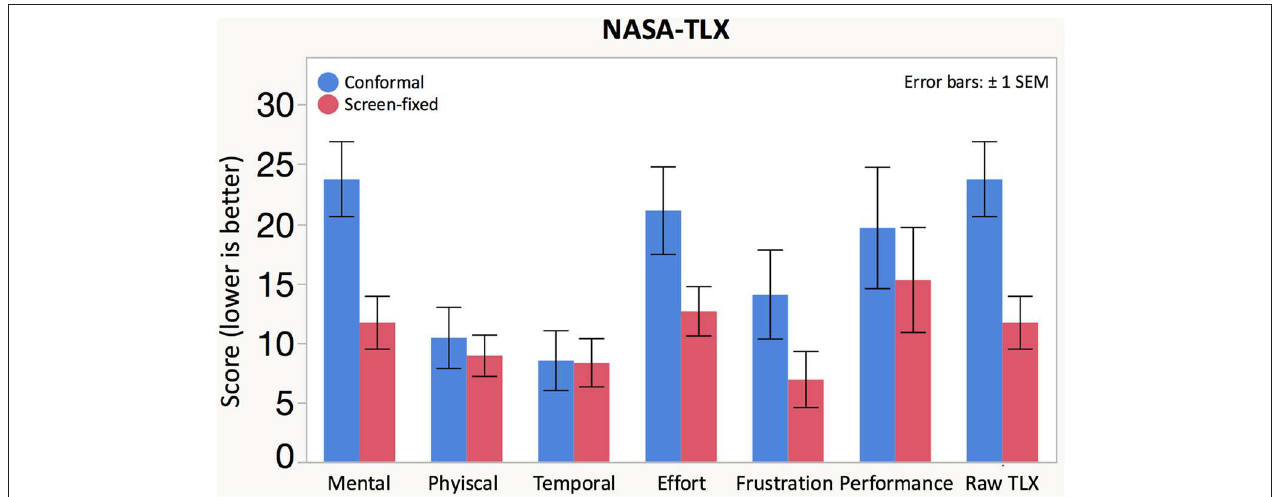
FIGURE 6 | Participants rated the NASA-TLX sub-scores on a scale of 0 (low demand) to 100 (high demand). The average of the sub-scores comprised the Raw TLX score.